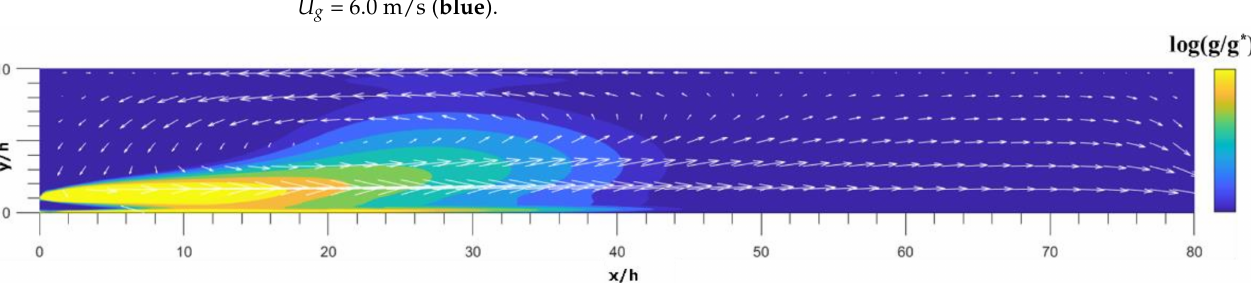
Figure 12. Comparison between the local breakup frequency ( g ) and the global estimate ( g* ). Note the logarithmic scaling. Vectors represent average velocity. ( p = 1, U g = 3.0